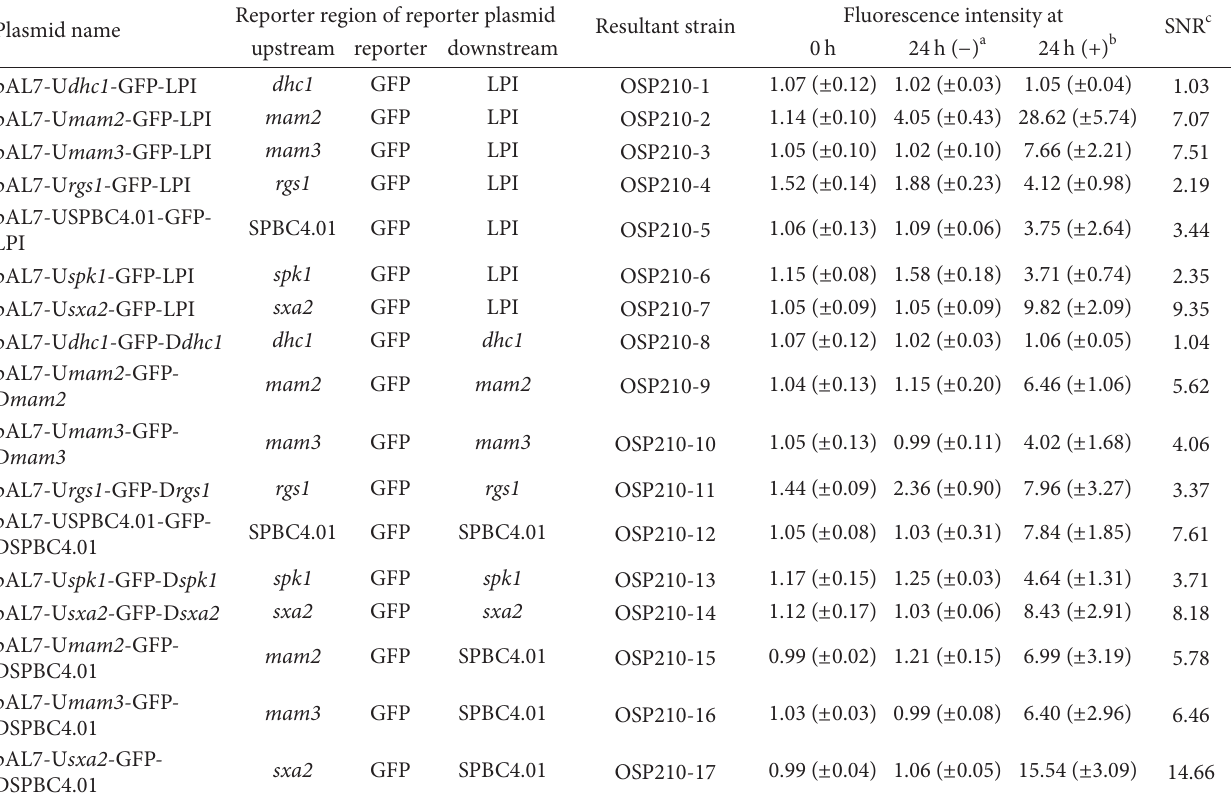
T 2: e reporter plasmids and the GFP production of those